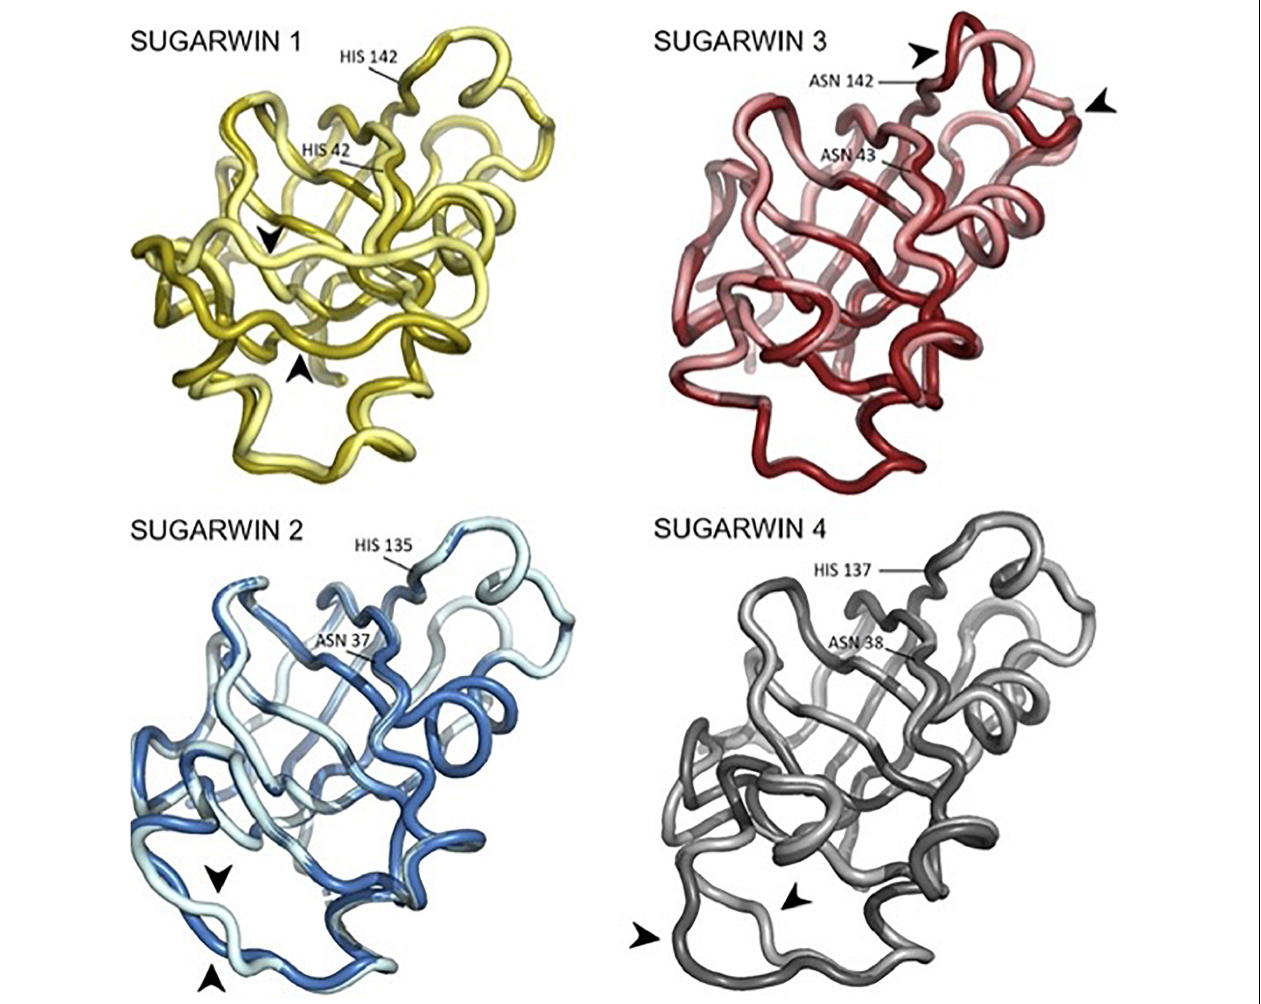
FIGURE 7 | PCA analysis of the SUGARWINs. Structures of SUGARWINs 1, 2, 3 and 4 generated by Bio3D PCA analysis indicating the main movements of each protein. Brighter and darker colors indicate extreme points of movements, extracted from PCA generated frames. Black arrowheads highlight regions of major flexibility. Residues in equivalent positions to the RNase active site histidines are